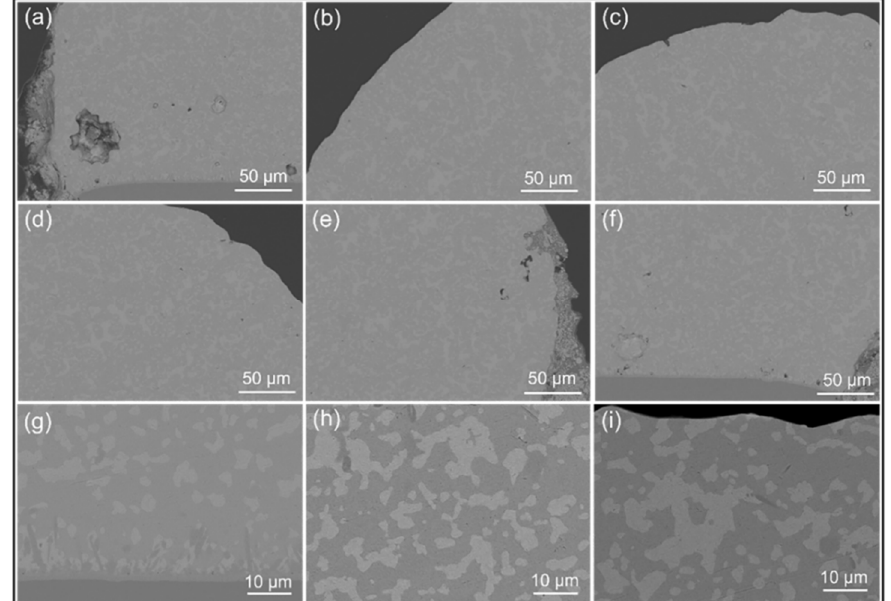
Figure 5. The fully mixed solder joint obtained after reflowing of 13.5Sn-37.5Bi-45In-4Pb solder and SAC305 at 140 °C for 5 min; ( a – f ): the 500× magnification of the lower left, left, upper-left edge, upper-right edge, right and lower right parts of the solder joint; ( g – i ): the 2000× enlarged view of the connection between the bottom of the solder joint and the Cu plate, the middle and top of the solder joint.